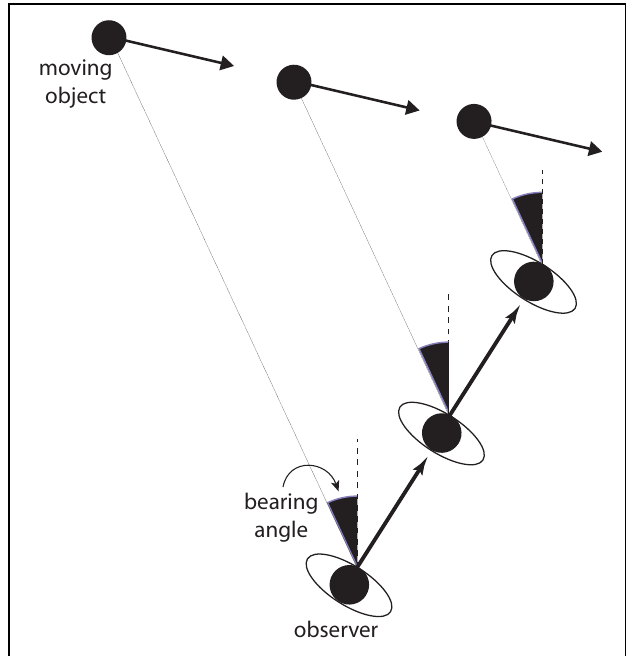
FIGURE 1 | The bearing angle model of interception and obstacle avoidance. The bearing angle is the angle between the object and reference direction that remains fixed in exocentric coordinates (dashed line). By keeping the bearing angle constant, the observer will eventually intercept the moving